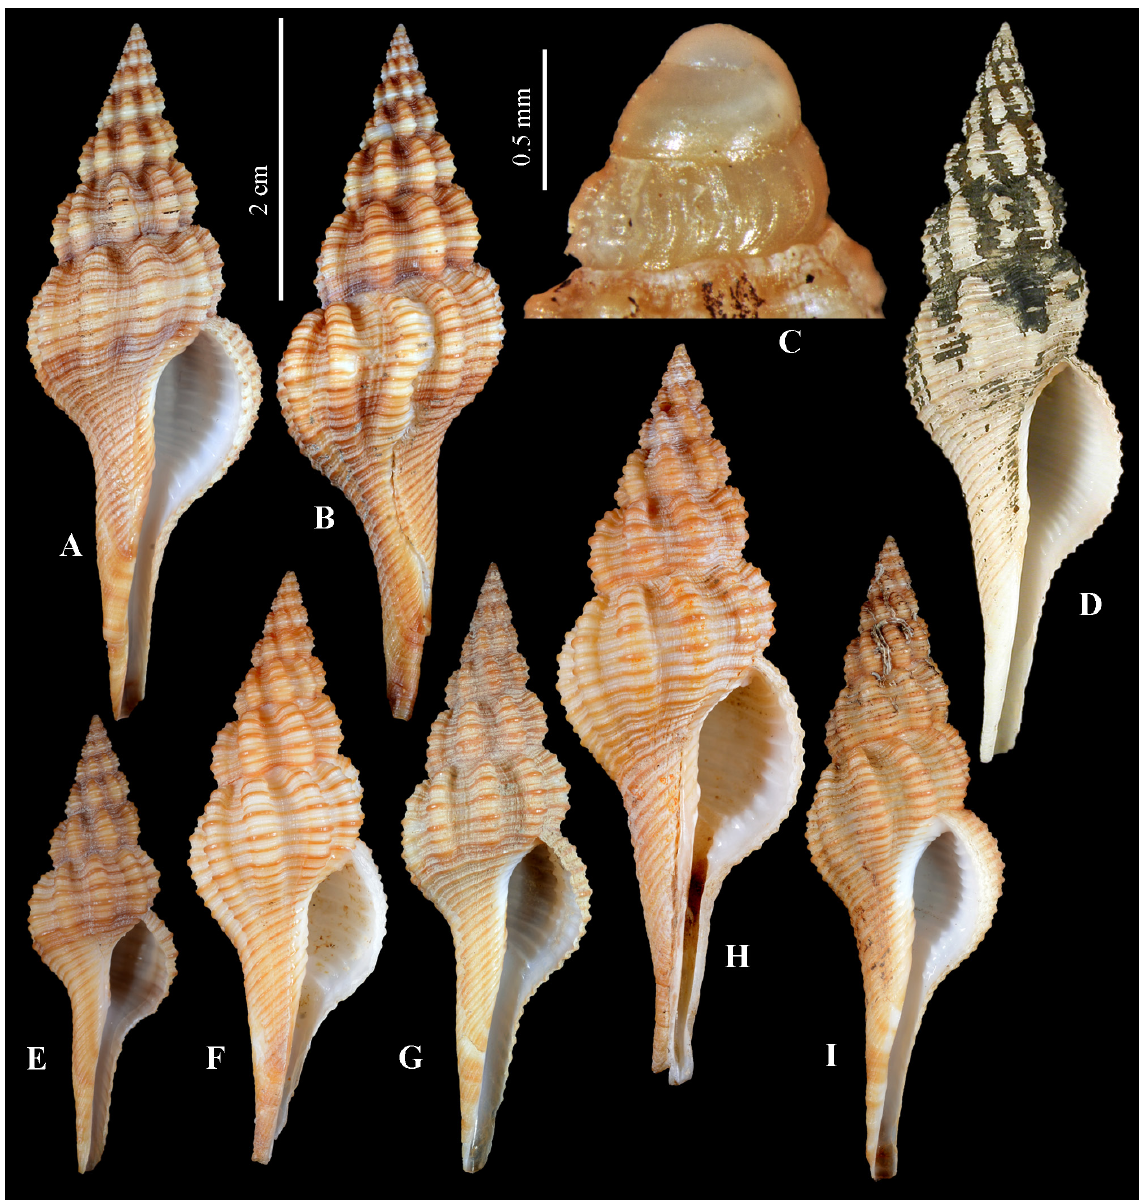
Fig. 6. Granulifusus annae sp. nov. A–C . Holotype, sequenced, SL 50.3 mm (MNHN IM-2013- 14709). C . Protoconch. D . Philippines, SL 54 mm, sequenced specimen (MNHN IM-2007-34486). E . New Caledonia, SL 23.1 mm, sequenced specimen (MNHN IM-2013-42520). F–G . New Caledonia, BATHUS 1, stn CP669, 20°57′ S, 165°35′ E, 255–280 m. F . SL 42.7 mm (radula, see Fig. 4E). G . SL 42.7 mm. H . New Caledonia, BATHUS 1, stn CP695, 20°35′ S, 164°58′ E, 410–430 m, SL 53.6 mm. I . Vanuatu, MUSORSTOM 8, stn CP1123, 15°07′ S, 166°55′ E, 262–352 m, SL 46.8 mm. All s hells to the same